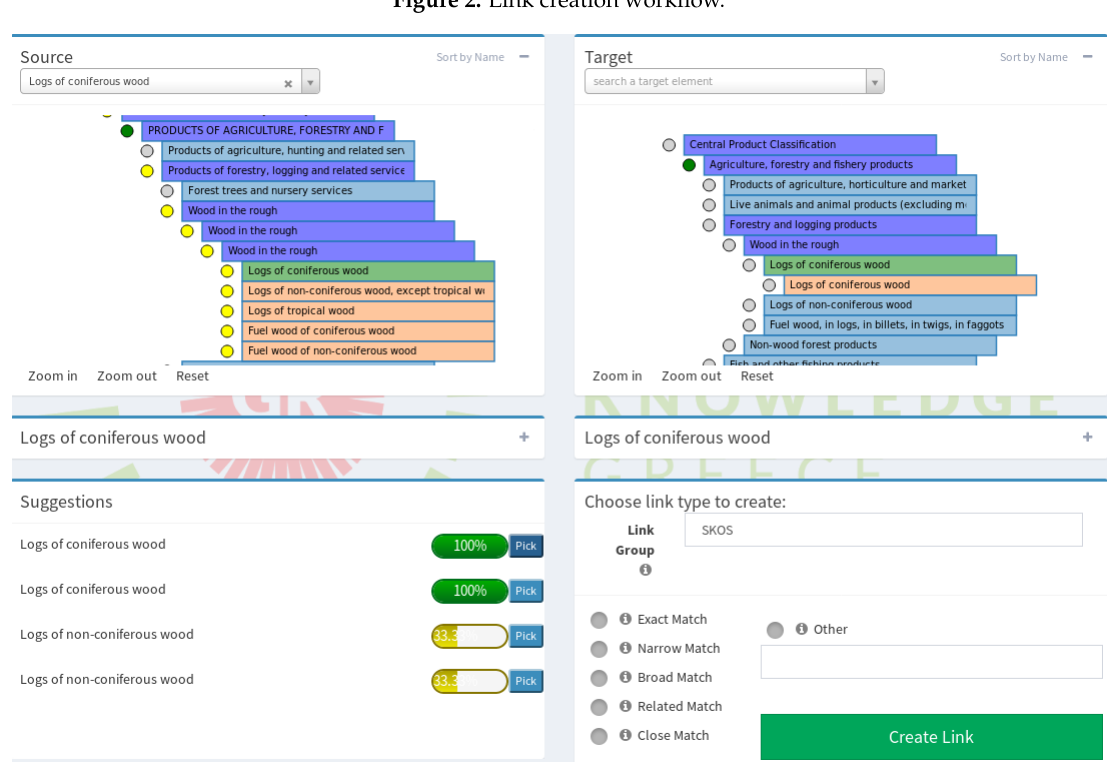
Figure 3. Alignment